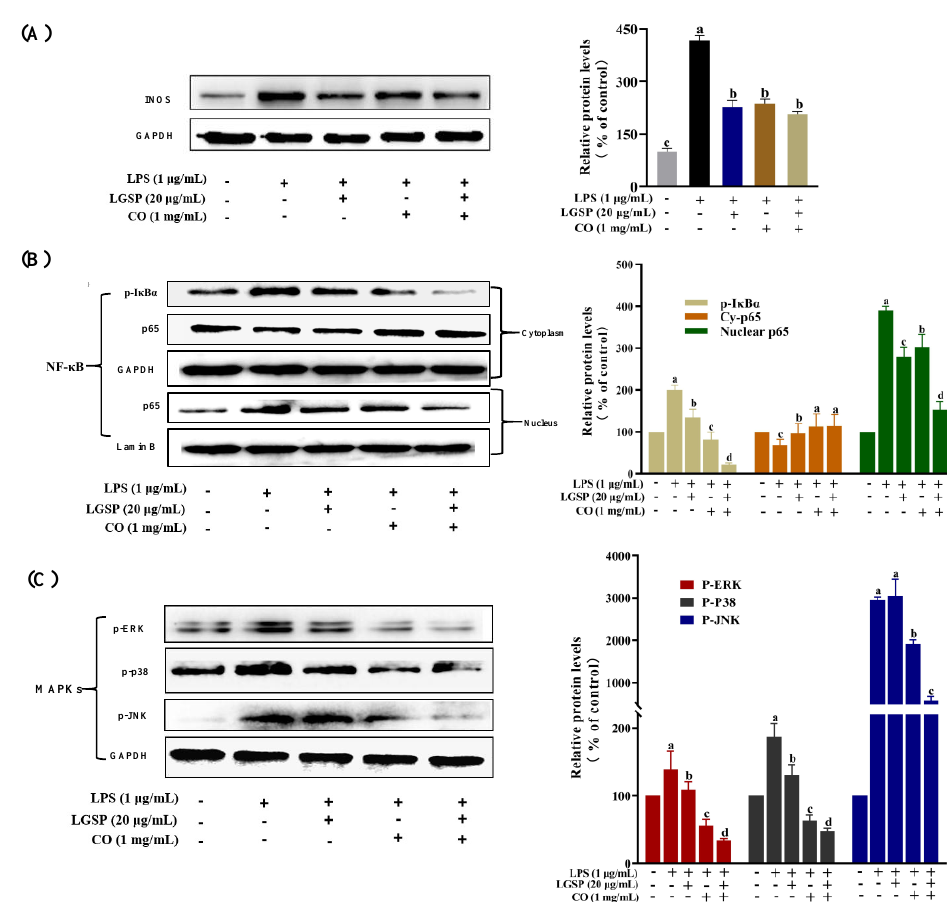
Figure 6. Effect of LGSP, CO and their combination on iNOS ( A ), NF- κ B ( B ) and MAPKs ( C ) signaling pathways. All values are means ± SD, n = 3. Different letters above the bars indicate significant differences ( p < 0.05).